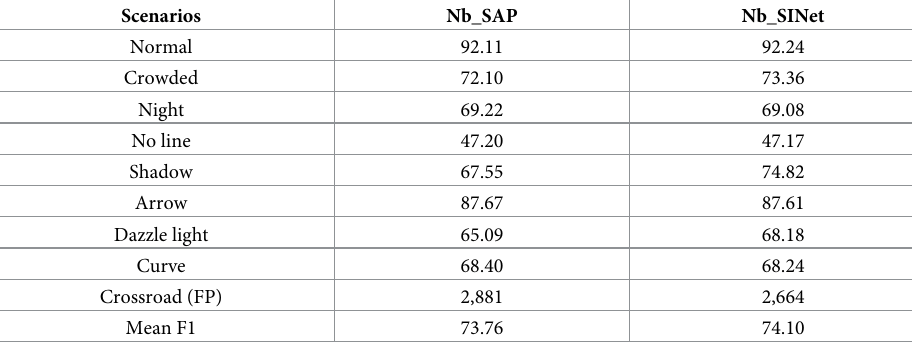
Table 3. Comparison between the F1 and FP metrics of Nb_SAP and Nb_SINet.